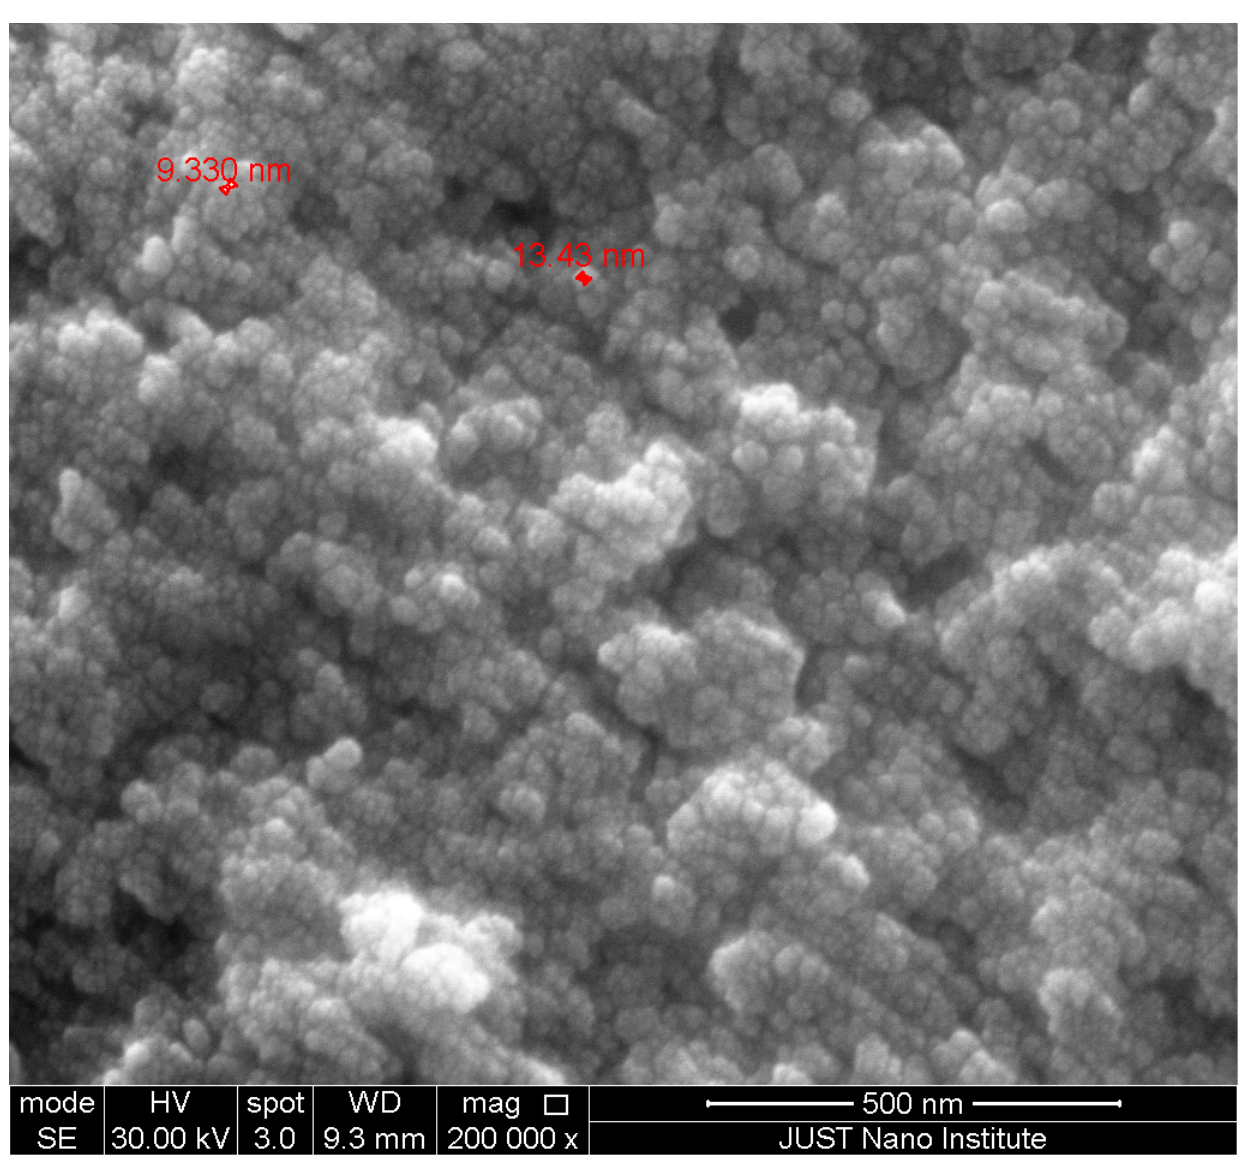
Table 2. Structure of the identified components of Sterculia diversifolia plant ethanolic